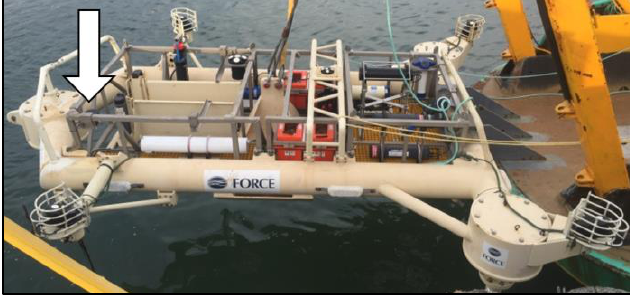
Fig. 1 FAST-1 sensor platform developed by FORCE and deployed at the FORCE test site. White arrow indicates location of AZFP transducer. Photo credit: Tyler